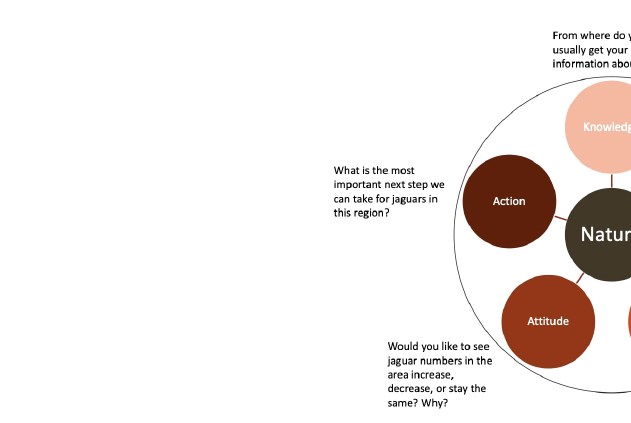
FIGURE 3 Conceptual model of fi ve aspects of an individual ’ s or a group ’ s nature: knowledge, perception, value, attitude, and action. Each aspect is represented by a sample question, one of several that were used to investigate that component in each